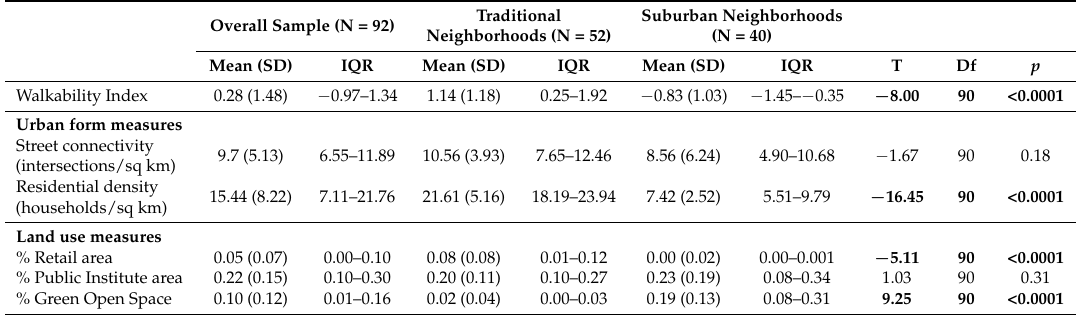
Table 2. Environmental variables as measured along the route to school (within a 25 m